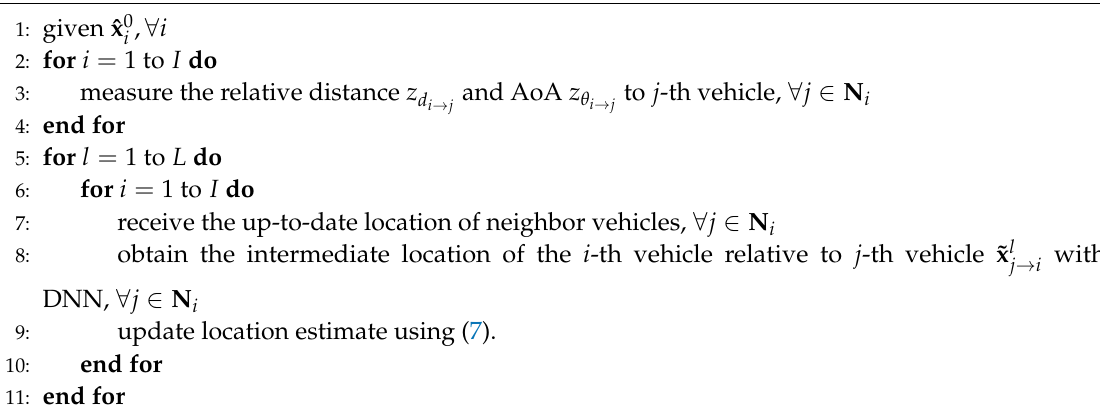
Algorithm 1 Proposed cooperative localization via deep neural network